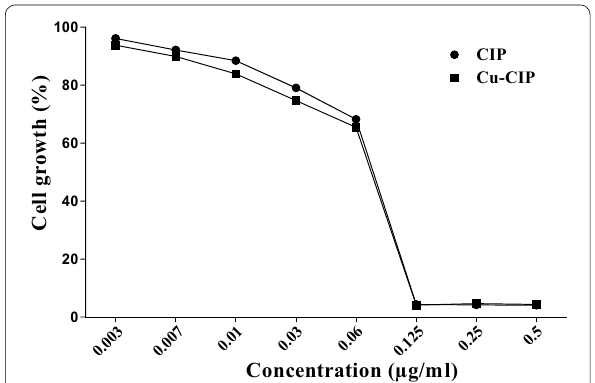
Fig. 3 The effect of concentrations of 0.003 to 0.5 µg/ml